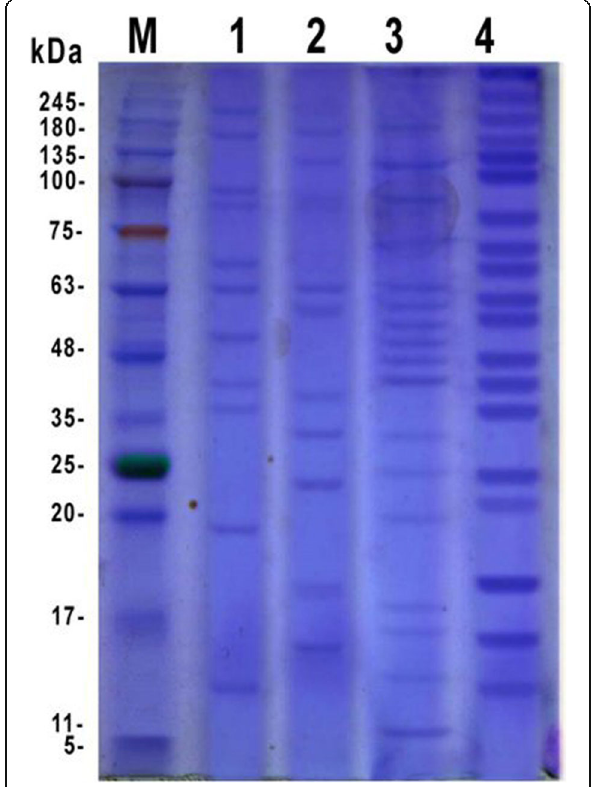
Fig. 3 SDS-PAGE of purified fat body lipase from G. mellonella larvae. M: molecular marker, 1: Fraction 17 after sephadex G-100 column, 2: Fraction 6 after loading column, 3: Sample after amm. Sulfate percipitation (40 – 80%), 4: Unpurified fat body extract